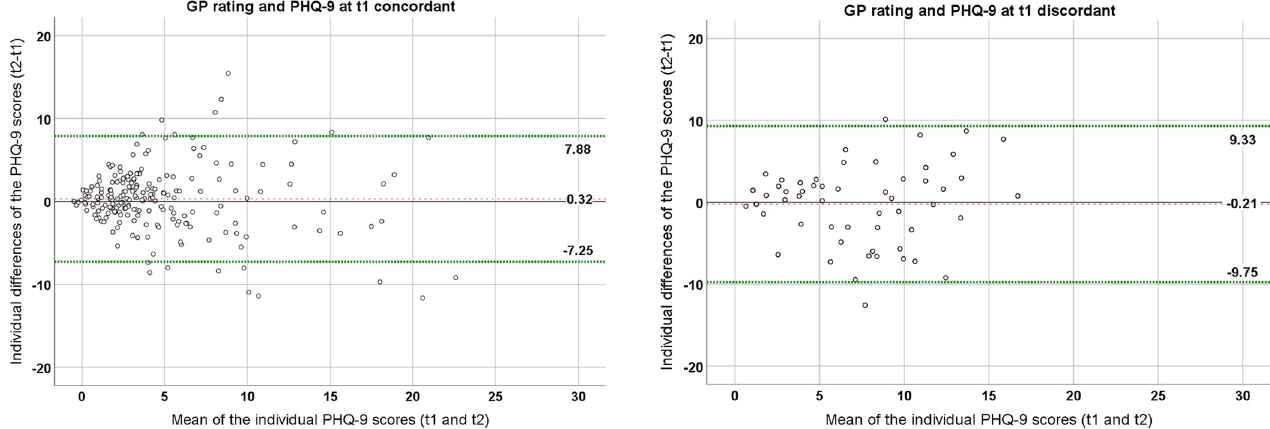
Fig 2. Bland-Altman Plots of the subgroups with a concordant vs. discordant GP rating and PHQ-9 results at t1 (dashed lines represent the Limits of Agreement and the